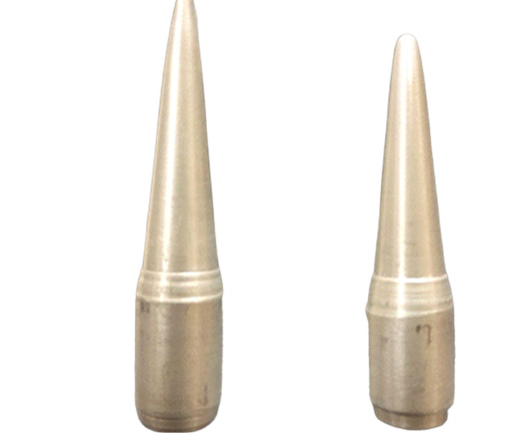
Aerospace 2022 , 9 , x FOR PEER REVIEW Figure 3. Prototypes of bullet head design I (left) and design II (right). Figure 3. Prototypes of bullet head design I ( left ) and design II ( right ).